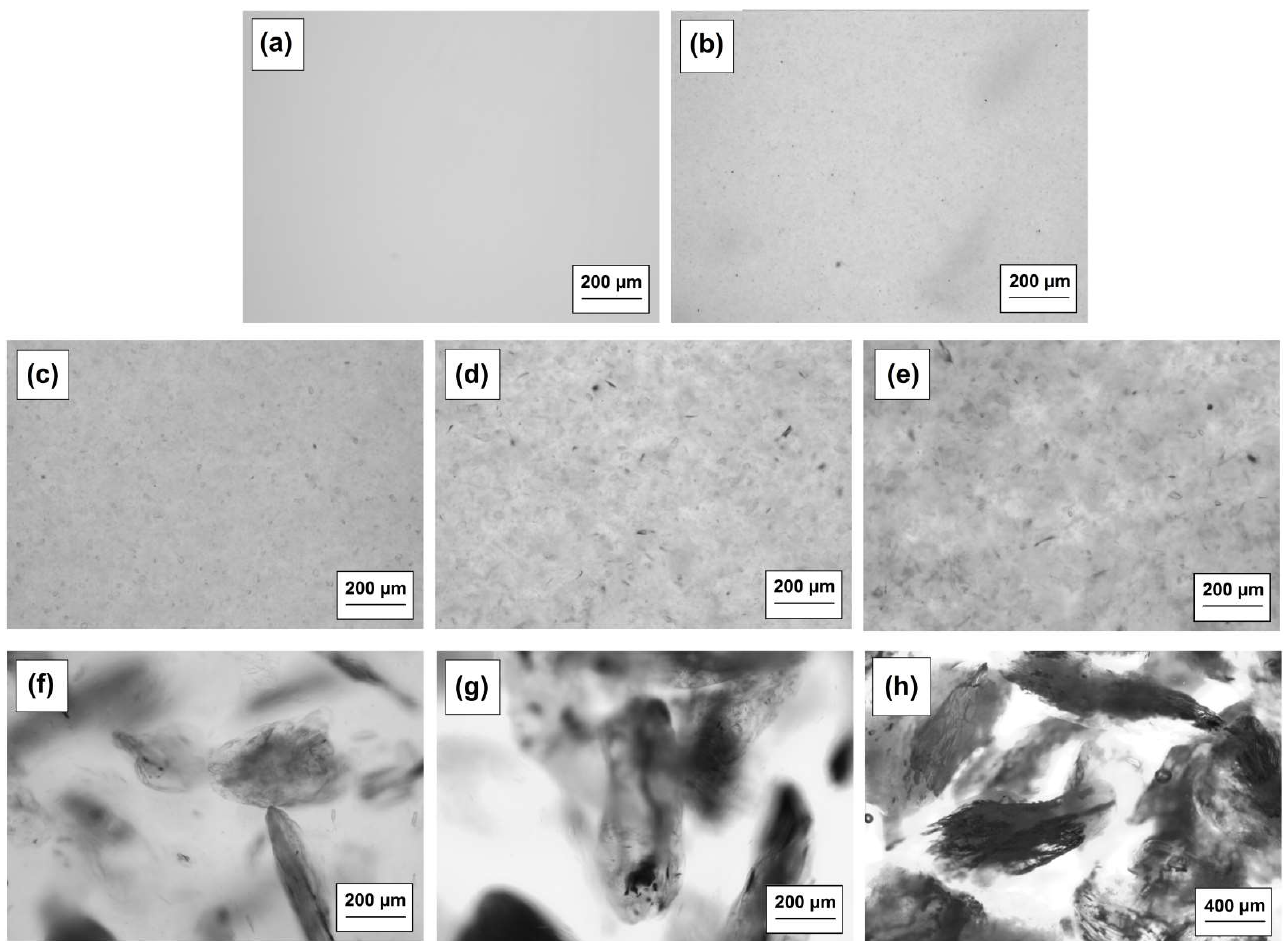
Figure 3. Photos of the composites made by the optical microscope: BPA.DM-NVP-0 ( a ), BPA.DM- NVP-1 ( b ), BPA.DM-NVP-2 ( c ), BPA.DM-NVP-3 ( d ), BPA.DM-NVP-4 ( e ), BPA.DM-NVP-5 ( f ), BPA.DM-NVP-6 ( g ) and BPA.DM-NVP-7 ( h ).